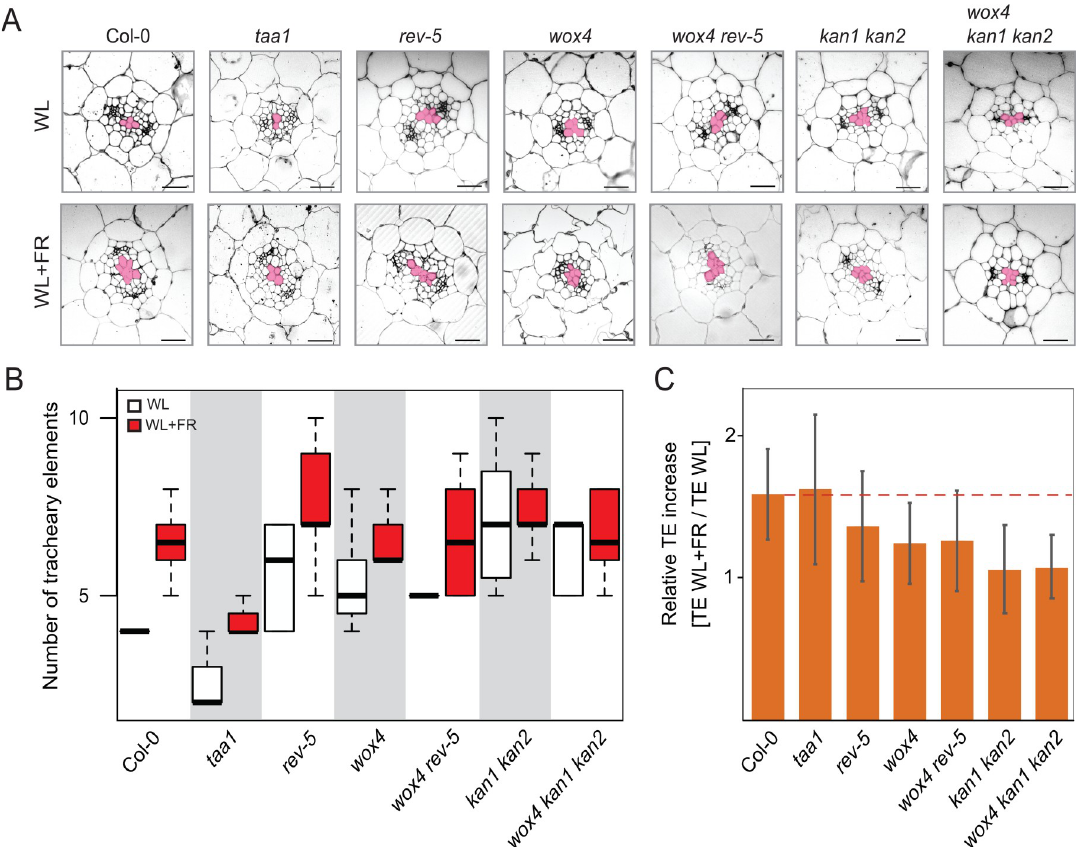
Fig 3. Shade-induced vascular patterning in mutants alters tracheary element formation. A , Representative images of hypocotyl cross sections of 10-day old seedlings grown in white light (WL) or shade (WL+FR) conditions. Pink colored areas mark the TE cells in the center of the vascular cylinder. Scale bars, 20 μ m. B , Box plots show the observed experimental data of TE numbers in WL and W +FR conditions for wild type and different mutants. Shown is the average of two biological replicates n = 9–13. Except taa1 which is based on one biological experiment n = 4–7. C, Relative TE increase by dividing the number of TEs in WL+FR with the number of TEs in WL. Red line indicates the ratio of the Col-0 wild